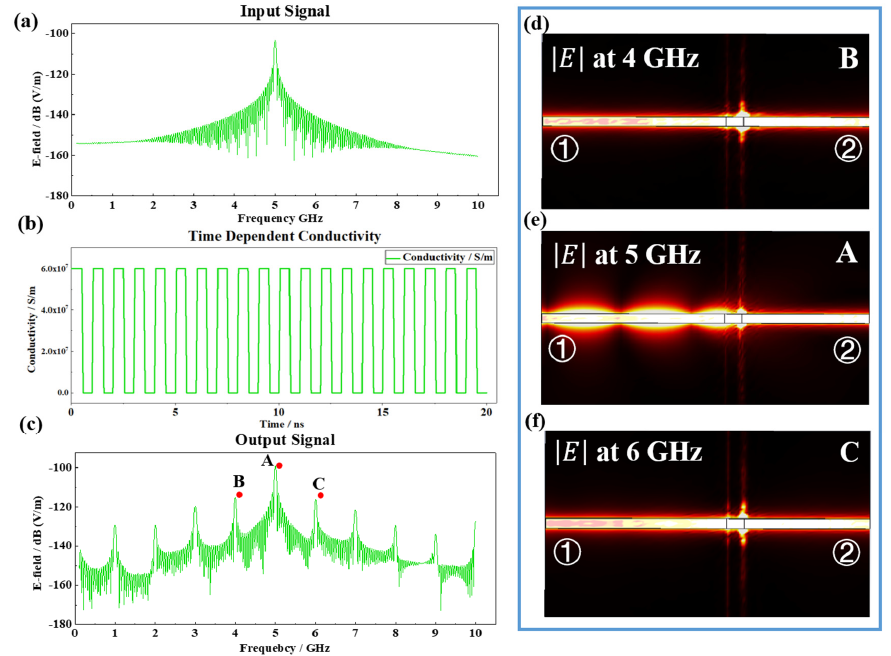
Figure 3. Microstrip in the dynamic case: ( a ) Spectrum of a monochromatic input signal; ( b ) Switching frequency of a conductivity-time-varying material is 1 GHz; ( c ) Spectrum of the output signal; ( d ) Output electric field distribution at 4 GHz; ( e ) Output electric field distribution at 5 GHz; ( f ) Output electric field distribution at 6 GHz.